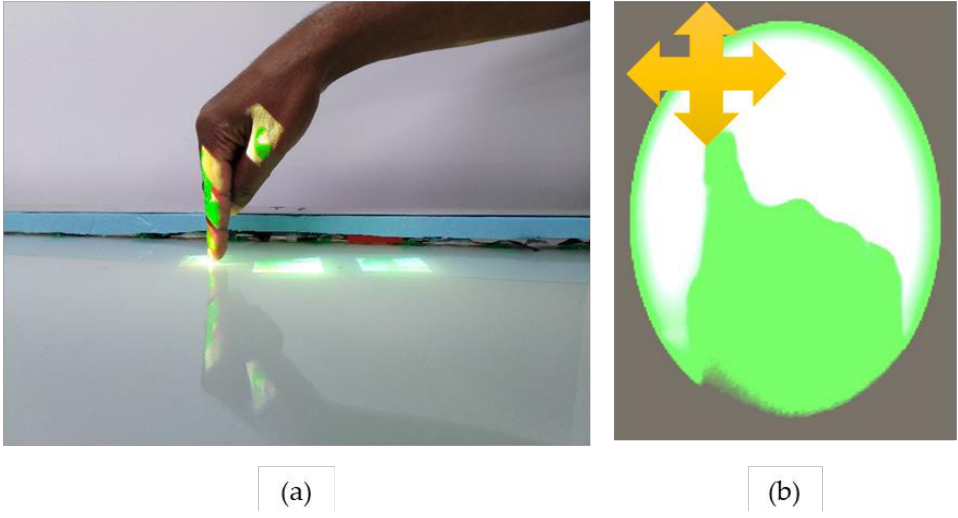
Figure 10. ( a ) Gesture Initialization; ( b ) Gesture Initialization Icons.